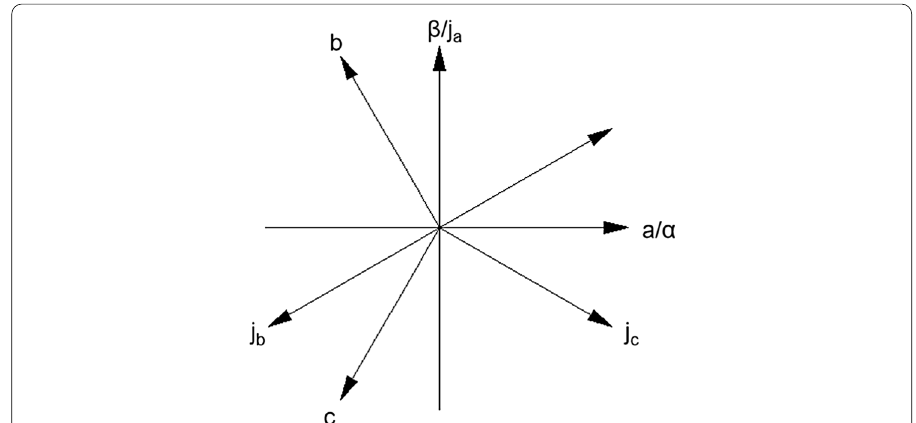
Fig. 2 The coordinate system of three phase virtual